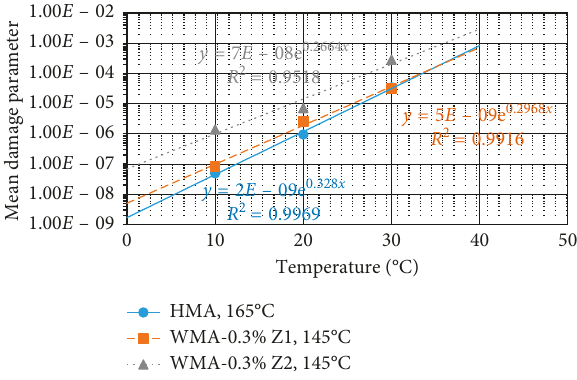
Figure 9: Mean damage parameter for the different mixtures under various testing